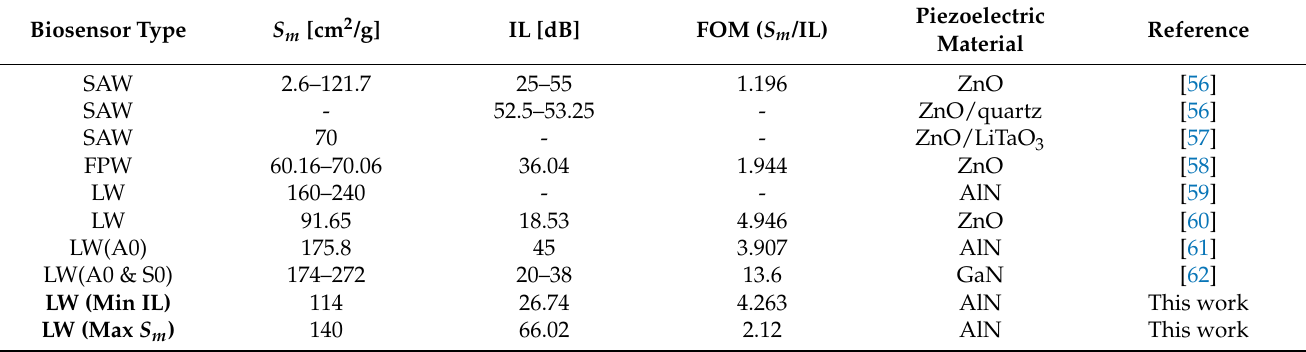
Table 2. Comparison of acoustic wave sensors’